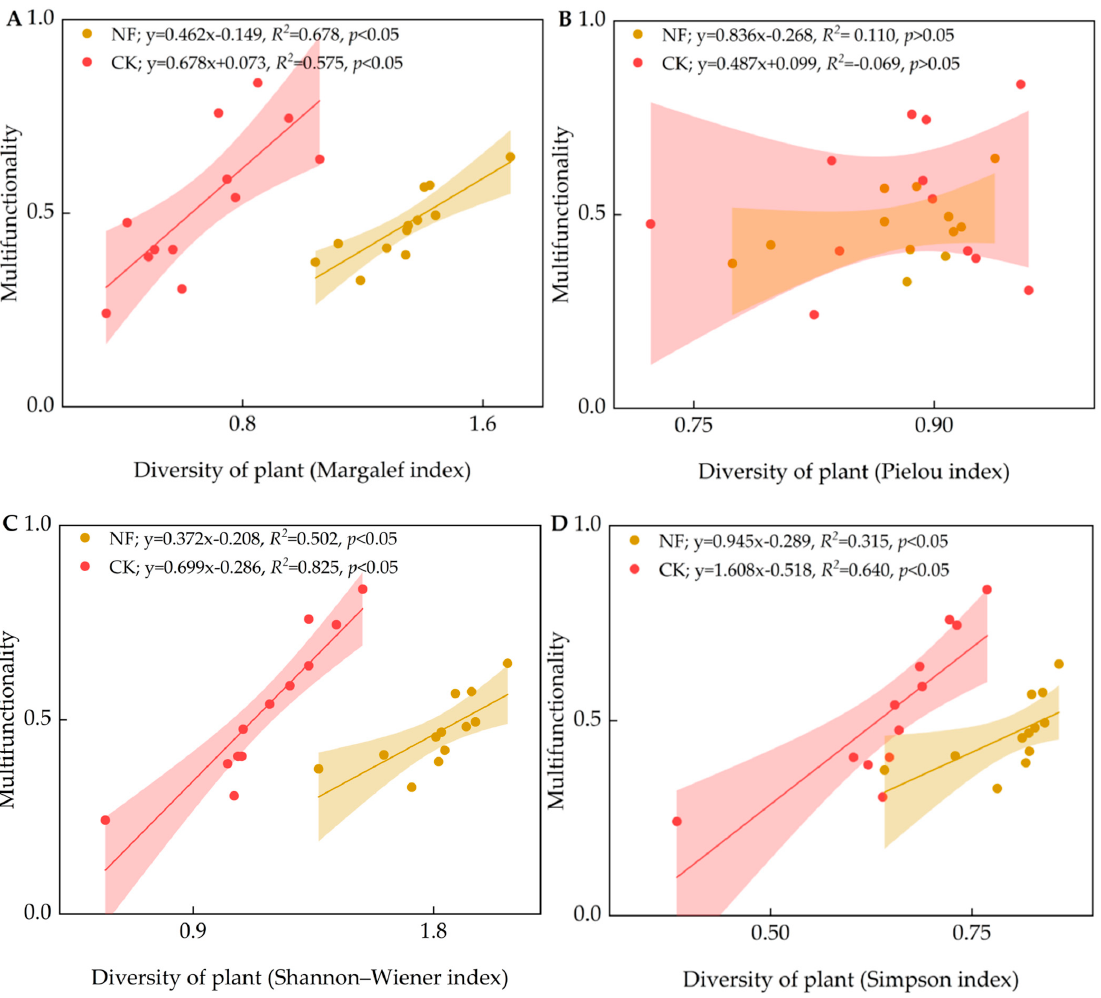
Figure 5. The relationship between plant diversity and ecosystem multifunctionality. Yellow and red colored dots indicate NF and CK, respectively. The translucent areas indicate 95% confidence intervals. ( A ), Margalef index of plant diversity; ( B ), Pielou index of plant diversity; ( C ), Shannon–Wiener index of plant diversity; ( D ), Simpson index of plant diversity.